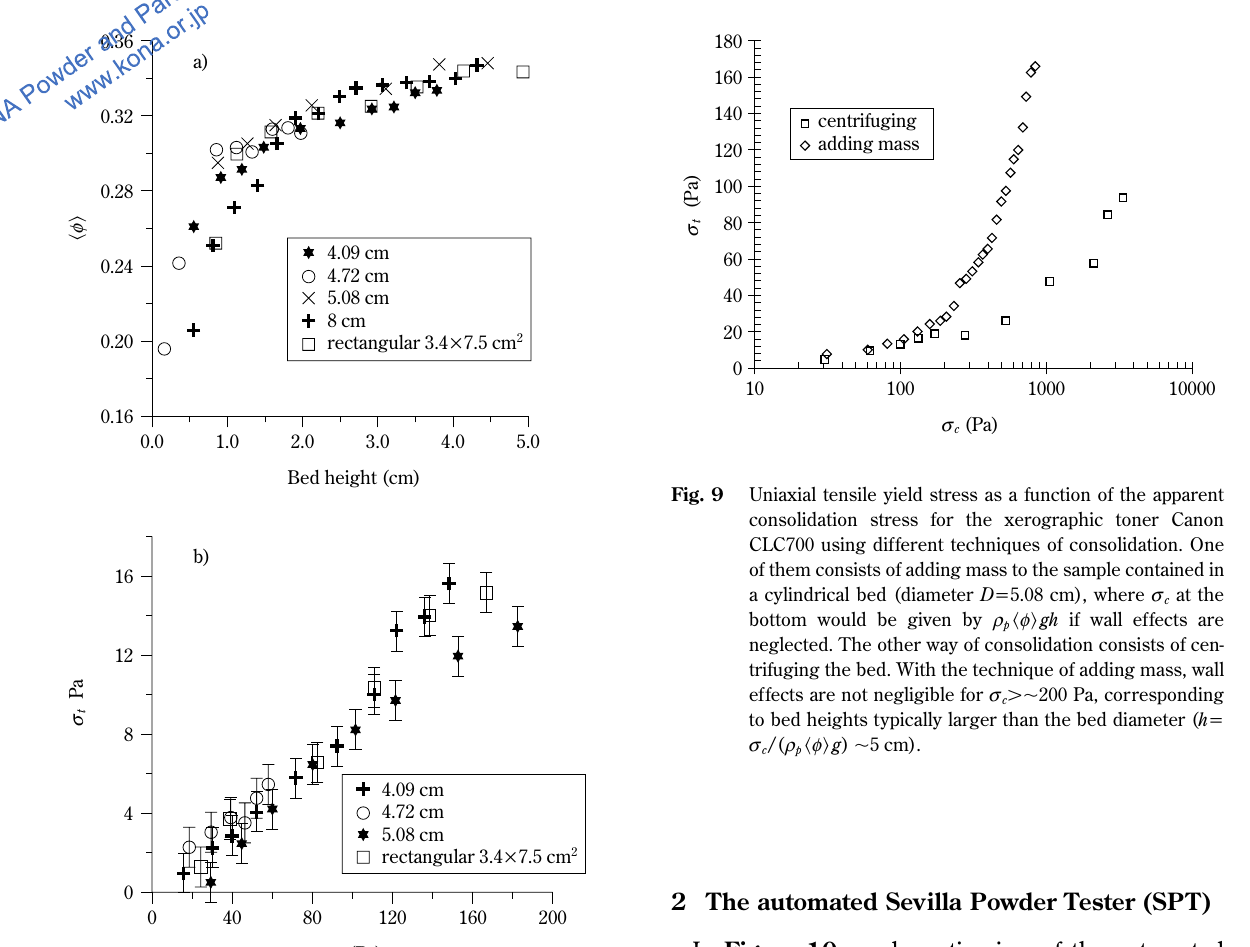
2 The automated Sevilla Powder Tester (SPT) In Figure 10 a schematic view of the automated SPT is shown. The main novelty is that by means of a series of computer-controlled valves, a controlled dry nitrogen flow can be pumped upward or downward through the bed while the gas pressure drop across the bed is read from the differential pressure trans- ducer. In this way, the gas flow can be used to auto- matically vary the consolidation stress on the powder while at the same time avoiding wall effects and inho- mogeneous gas distribution through shallow layers. To compress the powder over the sample weight per unit area after the powder has settled, the valves are operated to change the gas flow path to the reverse mode. Then the downward-directed gas flow is slowly increased from zero to a given value. The gas imposes a distributed pressure over the granular assembly pressing it against the distributor plate. The consolidation stress at the base of the bed is thus increased up to